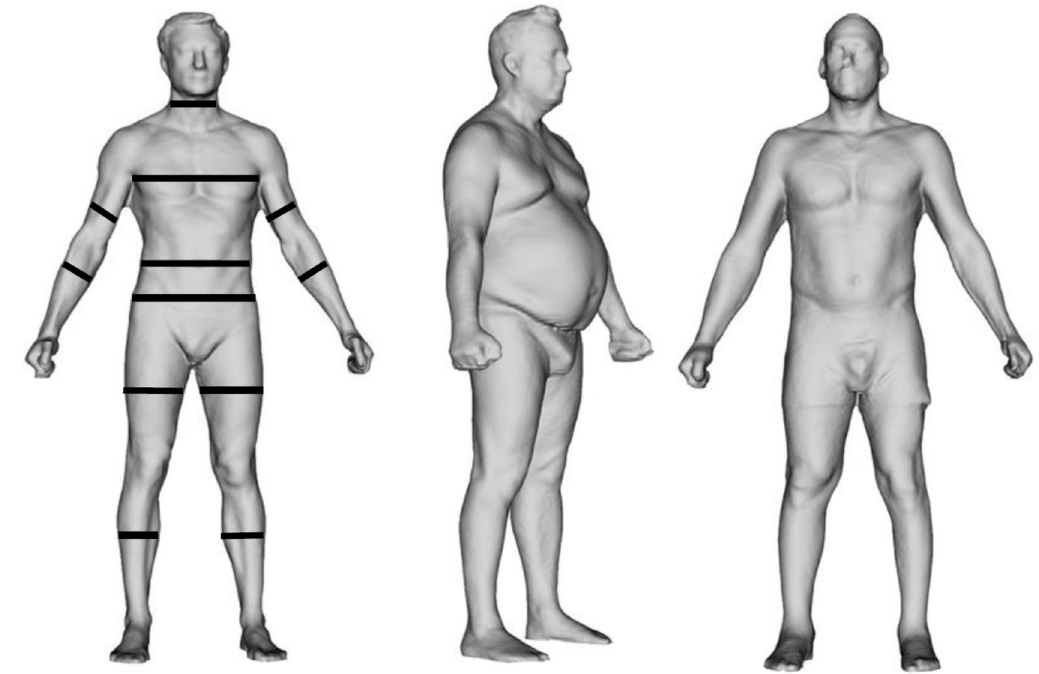
Figure 1. Representative avatars as provided by the software of the Fit3D ProScanner device (hardware version 5.0.6; software version 5.5.0—Fit3D Inc., San Mateo, CA, USA). ( Left panel ) a healthy male subject with standard circumference measurements (continuous black lines) provided by the software. NECK: circumference at mid-point of the neck (over the larynx). CHEST (in males): circumference at inner point of shoulder blades (BUST circumference in females is taken at the forwardmost protruding point above the waist). WAIST: circumference at the small of the back between the lower rib and top of the iliac crest. HIPS: circumference at the rearmost protruding point below the waist. BICEPS: max circumference of the arm between shoulder and elbow. FOREARM: max circumference of the arm between elbow and wrist. THIGH: max circumference of the leg between crotch and knee. CALF: max circumference of the leg between knee and ankle. ( Middle panel ) a male subject with obesity (body mass index: 34.2 kg/m 2 ) presenting increased waist circumference (123 cm). ( Right panel ) male patient with congenital inter-limb circumference asymmetries exacerbated following long-term unilateral immobilization of the upper and lower left limbs: right–left biceps: 39.3–33.7 cm; right–left forearm: 31.7–28.3 cm; right–left thigh: 63.1–57.8 cm; right–left calf: 40.9–36.3 cm. 5. European Phenotypic Variations throughout the Decades A recent study by Wong et al. [57] generated anthropometric measurements in hu- manoid avatars generated on the basis of body mass, height, age, and waist circumfer- ence data from nine NHANES surveys spaced over several decades between 1960 and 1962 and 2015 and 2018. The resulting images show how drastically the average Ameri- can’s body size and shape have changed over the last 40 years. These findings are con- sistent with previous studies showing that over the last decades the waist circumference values have increased beyond those expected from the increase in body mass index [58,59]. Changes in body size and shape have also occurred within European populations, as indicated by the results of several epidemiological studies performed in different Euro- pean countries [60–66]. We report in Figure 2 the time course of the waist circumference obtained during the last three decades from young and adult men and women of the Health Survey for England (HSE) population [67]. The biannual rate of change of the waist circumference was higher in women (0.61 cm/2 years, which corresponds to ~3 cm/decade) compared to men (0.54 cm/2 years, which corresponds to ~2.7 cm/decade).